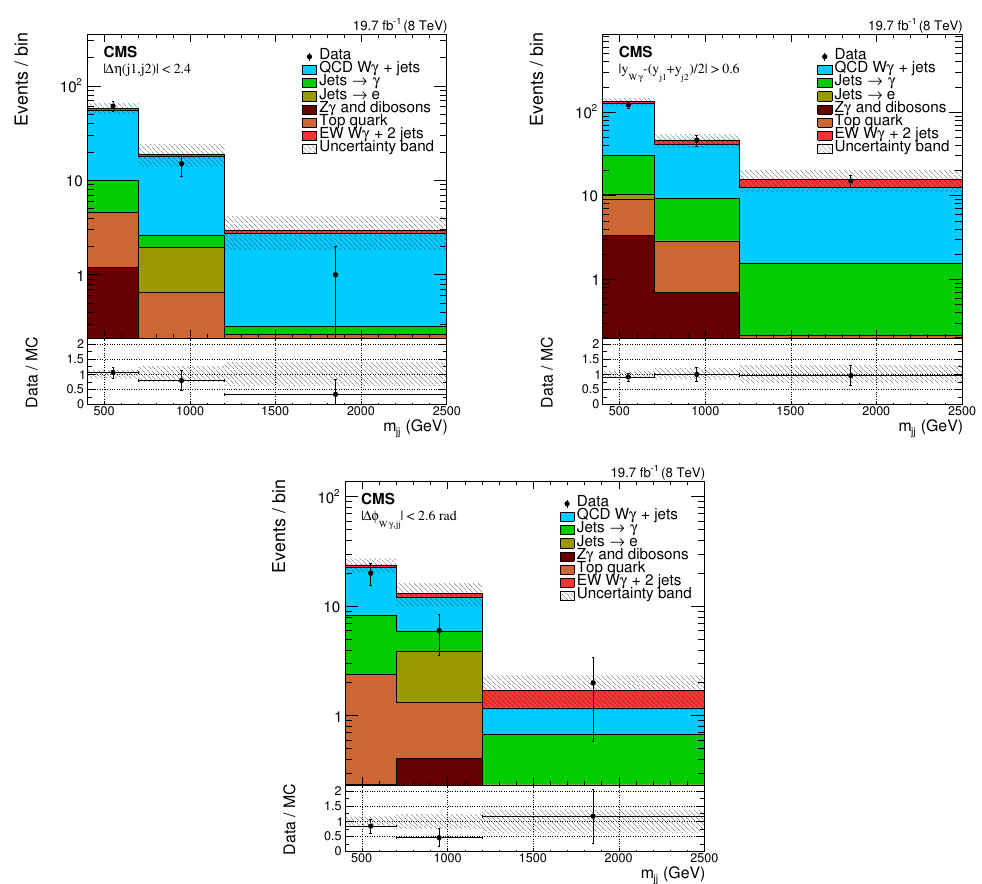
Figure 2 . The m jj distributions in orthogonal, but signal-like, regions obtained by inverting the signal selection criteria: j (cid:1) (cid:17) ( j 1 ; j 2) j < 2 : 4; j y W (cid:13) (cid:0) ( y j 1 + y j 2 ) = 2 j > 0 : 6; and j (cid:1) (cid:30) W (cid:13);jj j < 2 : 6 rad. Events from electron and muon channels are combined. Backgrounds from jets misidenti(cid:12)ed as photons (Jets ! (cid:13) ) and jets misidenti(cid:12)ed as electrons (Jets ! e) are estimated from data as described in the text. The diboson contribution includes WV(+ (cid:13) ) and Z (cid:13) (+jets) processes. The top quark contribution includes both the tt (cid:13) and single top quark processes. The signal contribution is shown on top of the backgrounds. The last bin includes the over(cid:13)ow events. The shaded area represents the total uncertainty in the simulation, including statistical and systematic